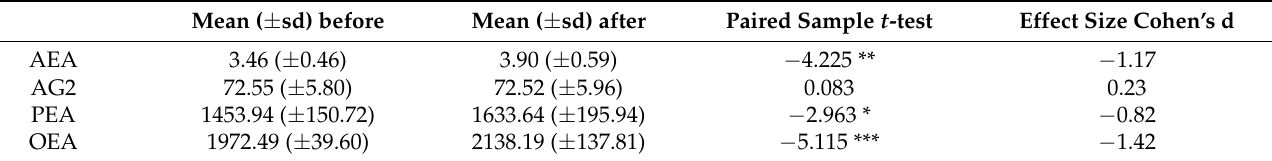
Table 3. Paired sample t-test for equality of AEA, AG2, PEA, and OEA mean values before and after intensive physical